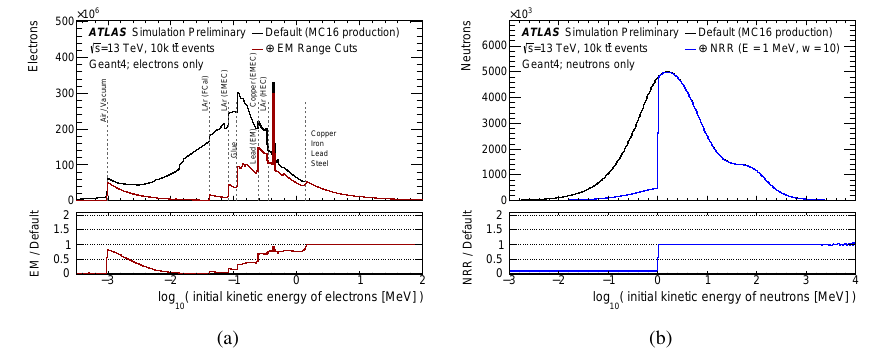
Figure 2: (a) Distribution of the initial kinetic energy of electrons in the ATLAS Geant4 simulation. The black curve shows the distribution for the default setup (MC16 production) and the red curve shows the distribution for the default setup plus the added Range Cuts for electromagnetic Geant4 processes (‘conv’, ‘phot’, ‘compt’). Vertical gray dashed lines indicate range cut values for some materials and the right-most dashed line indicates an area with multiple Range Cuts in close proximity for various metals. (b) Distribution of the initial kinetic energy of neutrons in the ATLAS Geant4 simulation. The black curve shows the distribution for the default setup (MC16 production) and the blue curve shows the distribution for the default setup plus the Neutron Russian roulette (NRR) algorithm with energy threshold 1 MeV and weight 10. Figures taken from ref. [4].